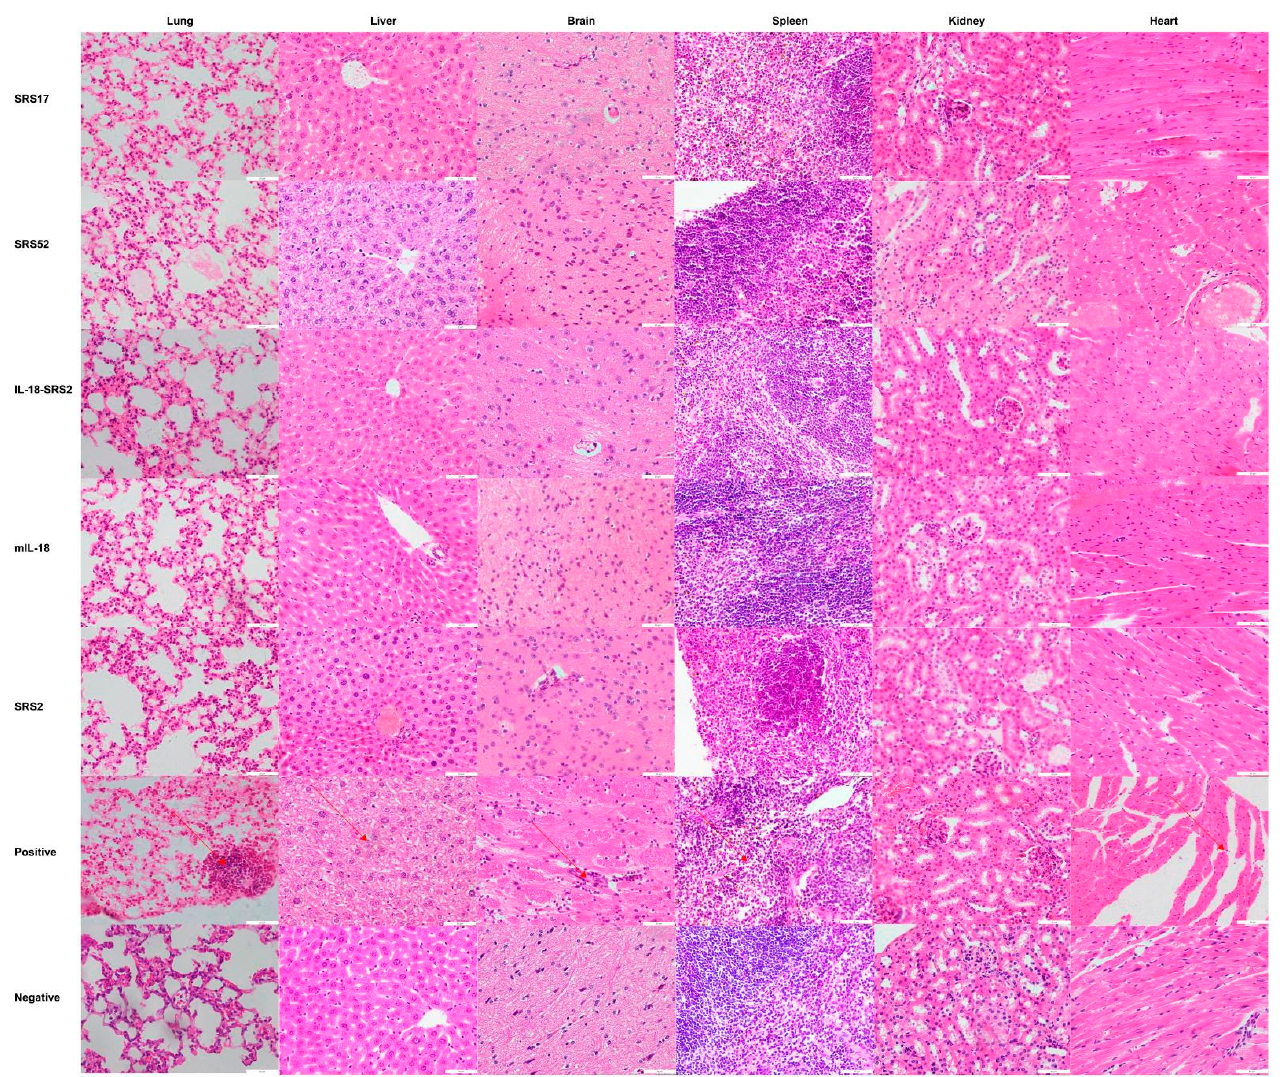
Figure 4. Histopathological changes in the heart, liver, spleen, lungs, kidneys and brain tissues of mice. The mouse was first immunized at 6 weeks, immunized a second time at 8 weeks and immunized a third time at 10 weeks. A histopathological analysis of heart, liver, spleen, lung, kidney and brain tissues of mice was conducted with HE staining, and observations were performed with a microscope at 20 days post infection. The brain, heart, liver, spleen, lung and kidney tissues were examined at a magnification of 200×.